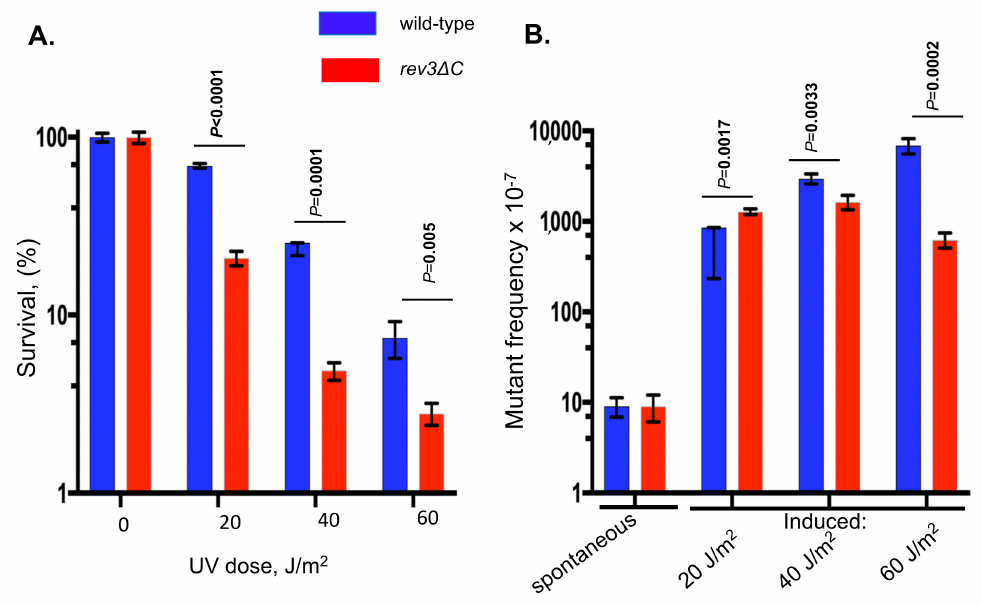
Figure 3. Survival ( A ) and mutagenesis levels ( B ) in UV-irradiated wild-type and rev3- ∆ C strains in comparison to untreated cells. Values are means from four independent experiments. Wild-type, blue • ; rev3 ∆ C , red (cid:4) . Data were collected and analyzed as described in the Section 2. The significance of the difference between wild-type and rev3- ∆ C strains was evaluated by a two-tailed unpaired Student’s t -test. Table 1. Differences in mutation specificity in wild-type and rev3- ∆ C